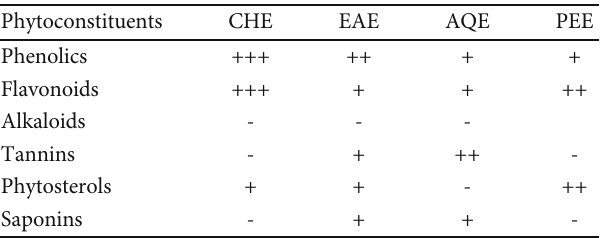
Table 1: Qualitative phytochemical analysis of di ff erent extracts of E . fl uctuans .